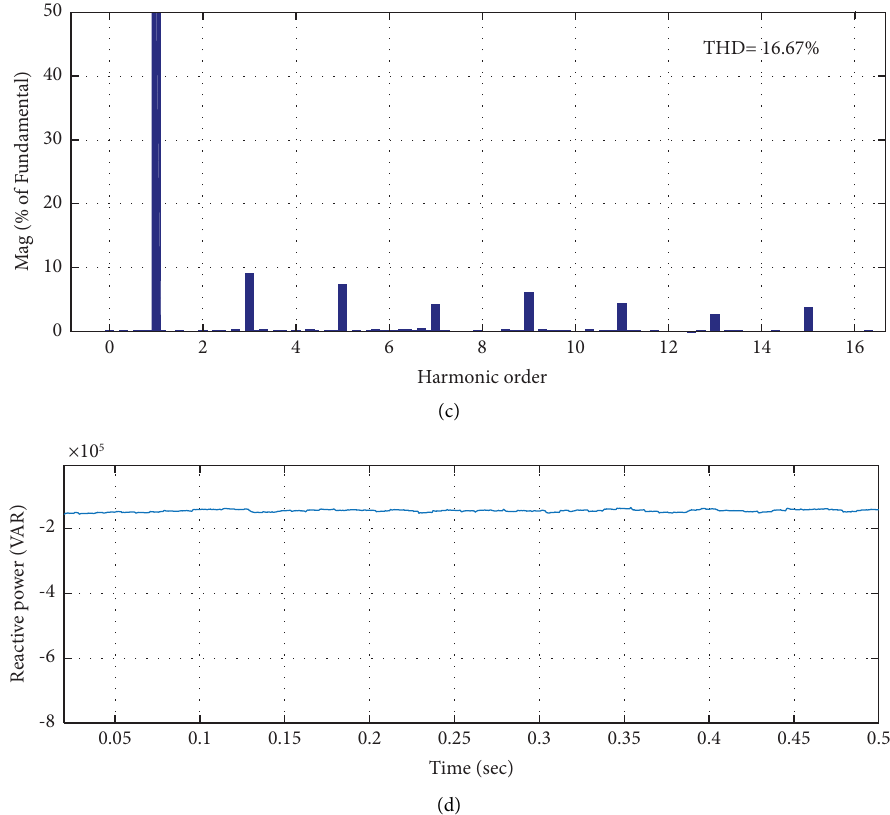
Figure 15: Performance during heavy nonlinear loading with SC-integrated APFs (a) Load voltage waveform, (b) load current waveform, (c) FFT analysis of load current, and (d) reactive power of the load.